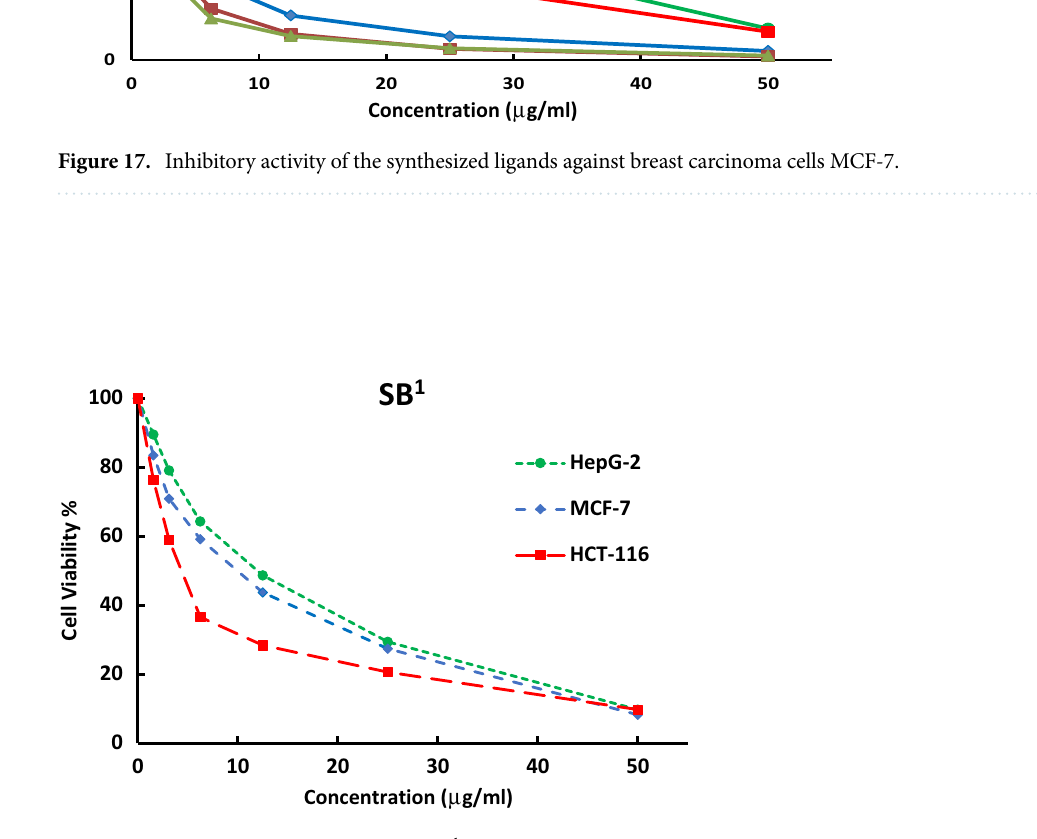
Figure 18. The inhibitory dose curves of SB 1 against three cell lines HepG-2, MCF-7, and